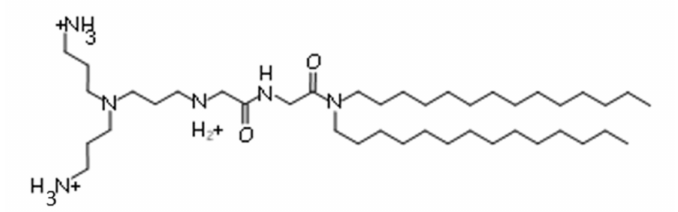
Figure 1. Chemical structure of 2-(3-[bis(3-aminopropyl)amino]propylamino)- N -ditetradecyl- carbamoylmethylacetamide (DMAPAP).